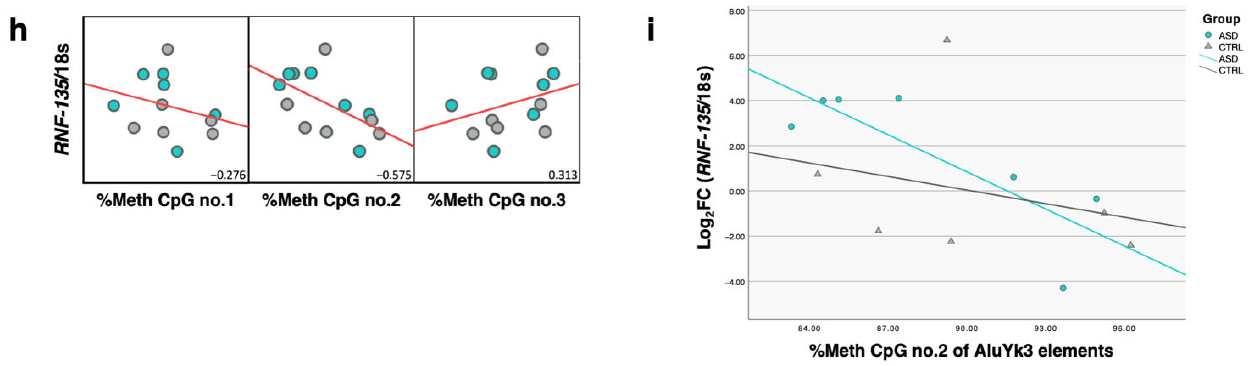
Figure 10. Locus-specific DNA methylation of AluYk3 located near the RNF-135 gene: ( a ) Illustration of AluYk3 elements located upstream of the RNF-135 gene. Three CpG sites in AluYk3 were determined using the COBRA method created with BioRender.com (accessed on 20 January 2023). ( b – d ) Box plots of AluYk3 methylation at three CpG sites in ASD and unaffected individuals. ( e – g ) Box plots of AluYk3 methylation at three CpG sites in ASD subtypes (NV-ASD and V-ASD) and unaffected individuals. ( h ) A correlation matrix between AluYk3 methylation and expression of RNF-135 (red lines represent trend lines; linear model) ( i ) Scatter plots between AluYk3 methylation (CpG no. 2) and expression of RNF-135 in ASD and unaffected individuals. * p < 0.05.